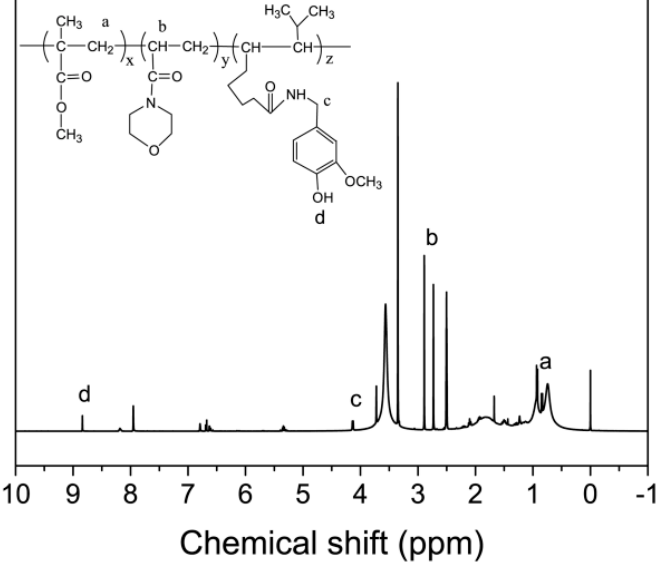
Figure 1. 1 H-NMR spectrum of PMMA-PACMO-Capsaicin copolymer.